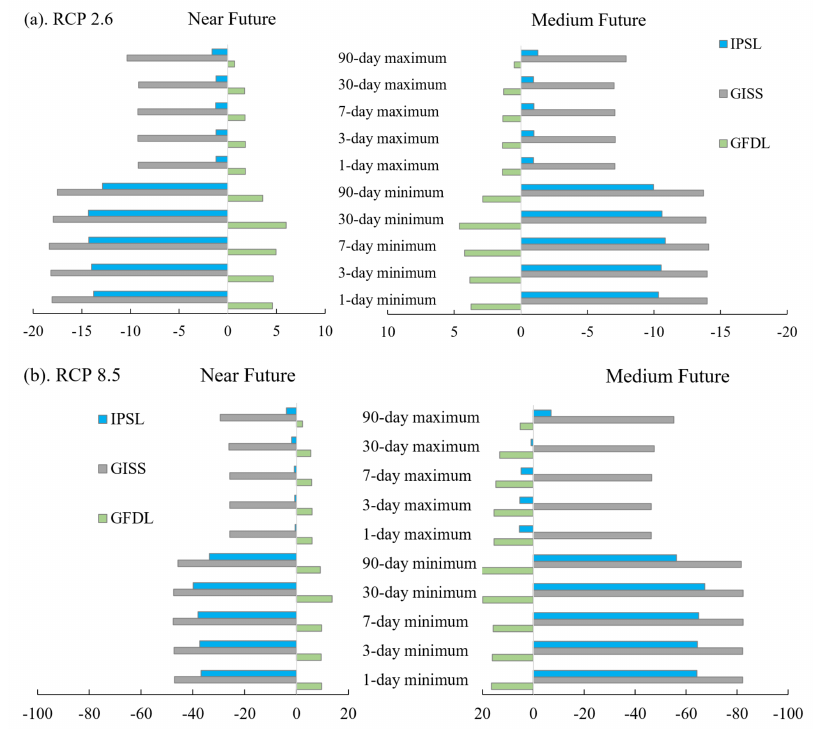
Figure 6. The percentage change of streamflow in multiple temporal scales under different climate scenarios: ( a ) RCP2.6 and ( b )